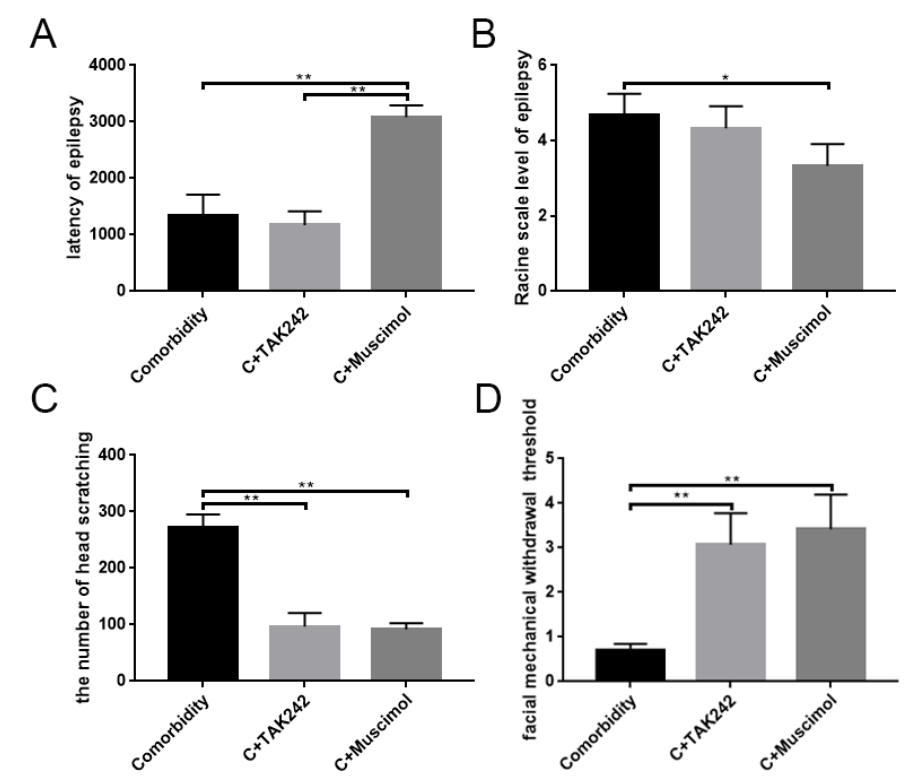
Figure 8. The GABAAR α 1-TLR4 signal regulates epilepsy–migraine comorbidity. ( A ) Significant differences in latency of epilepsy were observed between comorbidity ( n = 3) and comorbidity + Muscimol ( n = 3, ** p < 0.01), comorbidity + TAK-242 ( n = 3) and comorbidity + Muscimol ( n = 3, ** p < 0.01). No significant difference between comorbidity and comorbidity + TAK-242. ( B ) Application of Muscimol reduces the Racine scale level of epilepsy in comorbidity ( n = 3, * p < 0.05). The amount of head scratching ( C ) and facial mechanical withdrawal threshold ( D ) were evaluated, and phenotype improvements were detected from comorbidity + TAK-242 ( n = 3) and comorbidity + Muscimol rats ( n = 3, ** p < 0.01). C: